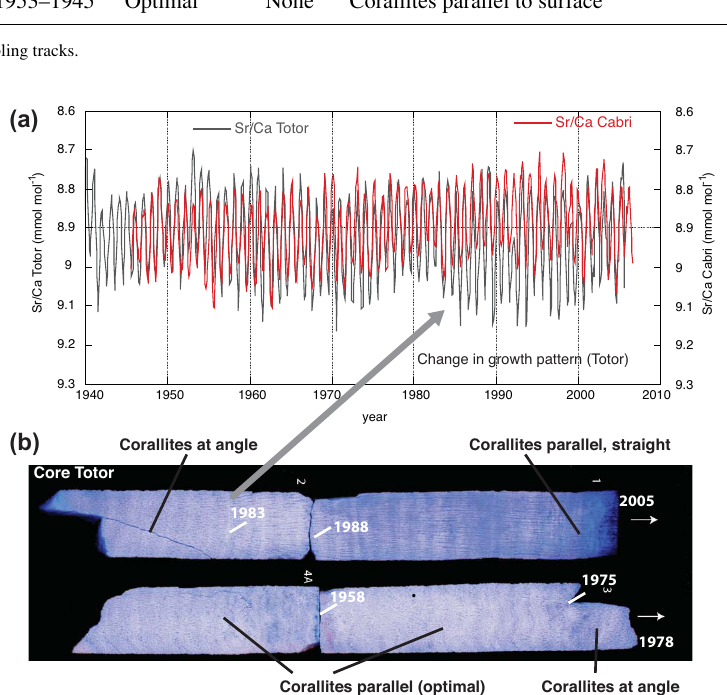
Figure 9. (a) Monthly interpolated Sr / Ca profiles for cores Cabri (red) and Totor (grey). (b) Images of core Totor (coloured blue) with orientation of corallites indicated. Years for core sections indicated on coral slab and grey arrow points to major change in growth pattern in the Totor core top section around the years